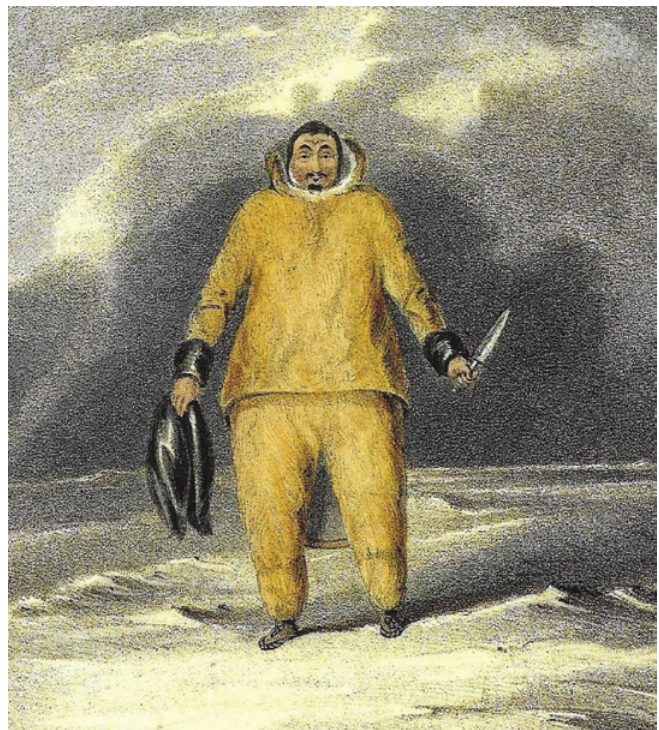
Figure 2. Inuit man wearing polar bearskin. Source : Ross, Second Voyage, Appendix 31, 33, 39 and